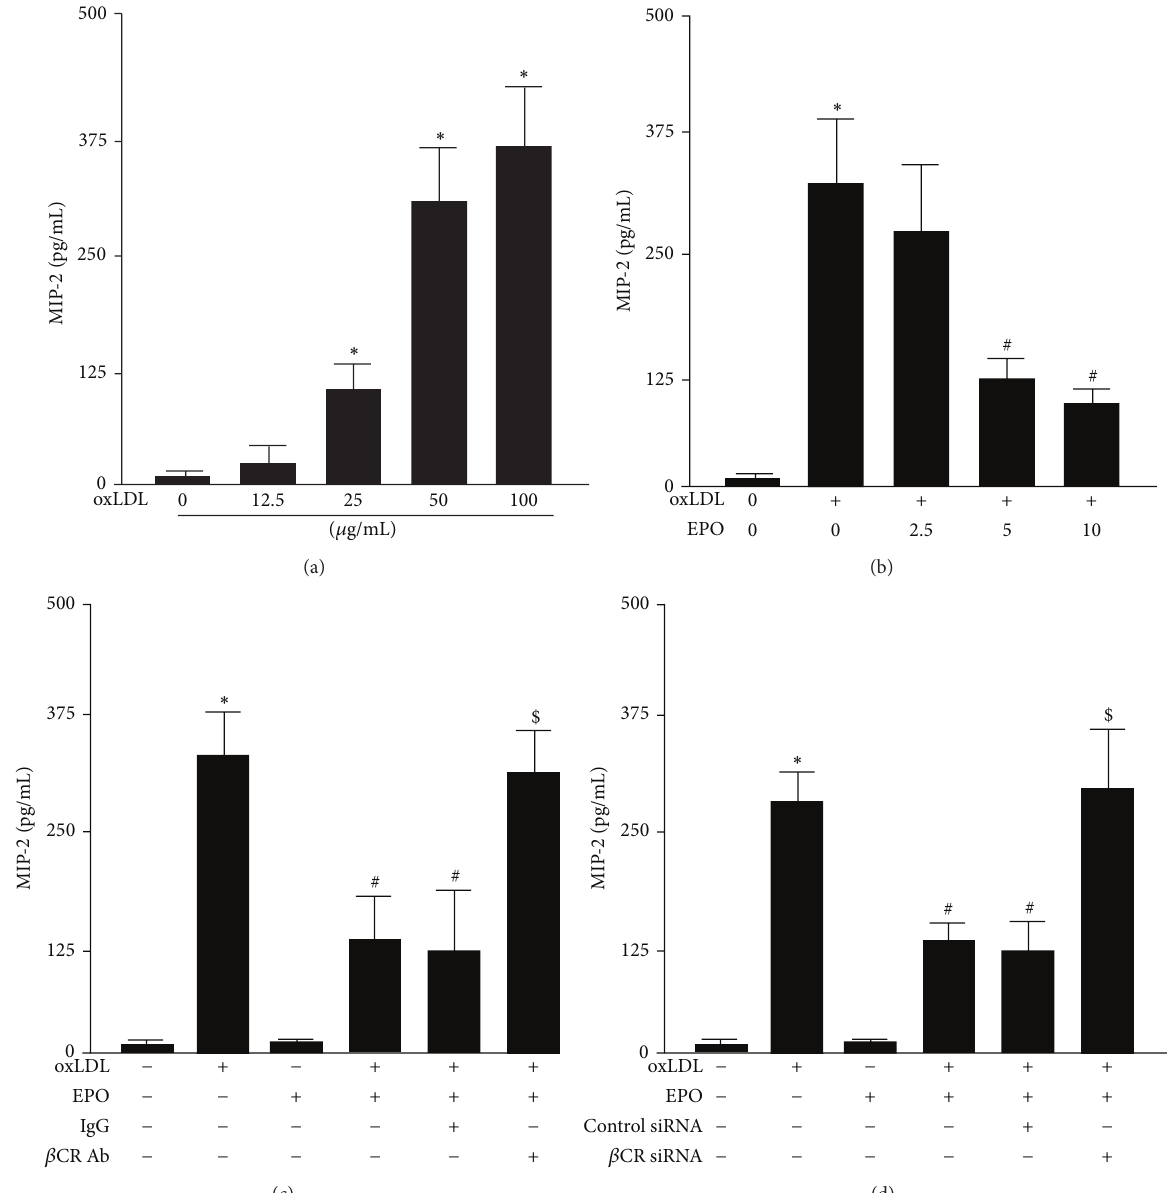
Figure 8: Inhibition of 𝛽 CR activation prevents the protective effect of EPO against from the oxLDL-induced MIP-2 production in macrophages. (a) BMDMs were treated with indicated concentrations of oxLDL (12.5, 25, 50, and 100 𝜇 g/mL) for 24 h. (b) Cells were treated with oxLDL (50 𝜇 g/mL) in the absence or presence of indicated concentrations of EPO (2.5, 5, and 10U/mL) for 24h. (c) Cells were pretreated with IgG (200ng/mL) or 𝛽 CR neutralizing Ab (200ng/mL) for 2h or (d) transfection with control siRNA (50nmole/L) or 𝛽 CR siRNA (50 nmole/L) for 24 h and then treated with oxLDL (50 𝜇 g/mL) and EPO (5U/mL) for an additional 24h. Levels of MIP-2 in cultured medium were analyzed by ELISA. Data are mean ± SD from 5 independent experiments. ∗ 𝑃 < 0.05 versus vehicle-treated group, # 𝑃 < 0.05 versus oxLDL alone-treated group, and $ 𝑃 < 0.05 versus oxLDL-treated group with